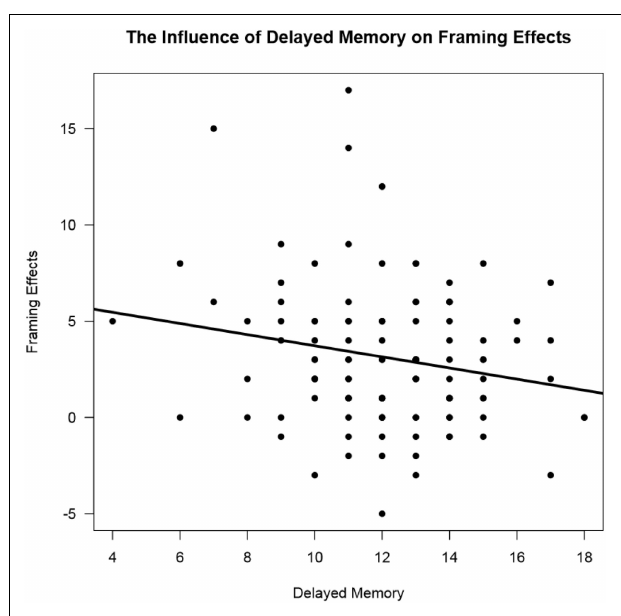
FIGURE 6 | The influence of delayed memory on framing effects. A scatter plot of scores on a measure of delayed memory and framing effects. The amount deviation from 0 in framing effects represents the amount of susceptibility to framing bias. The solid line represents the influence of delayed memory on framing effects [ F (1,193) = 4.53, p = 0.03] which was significant.